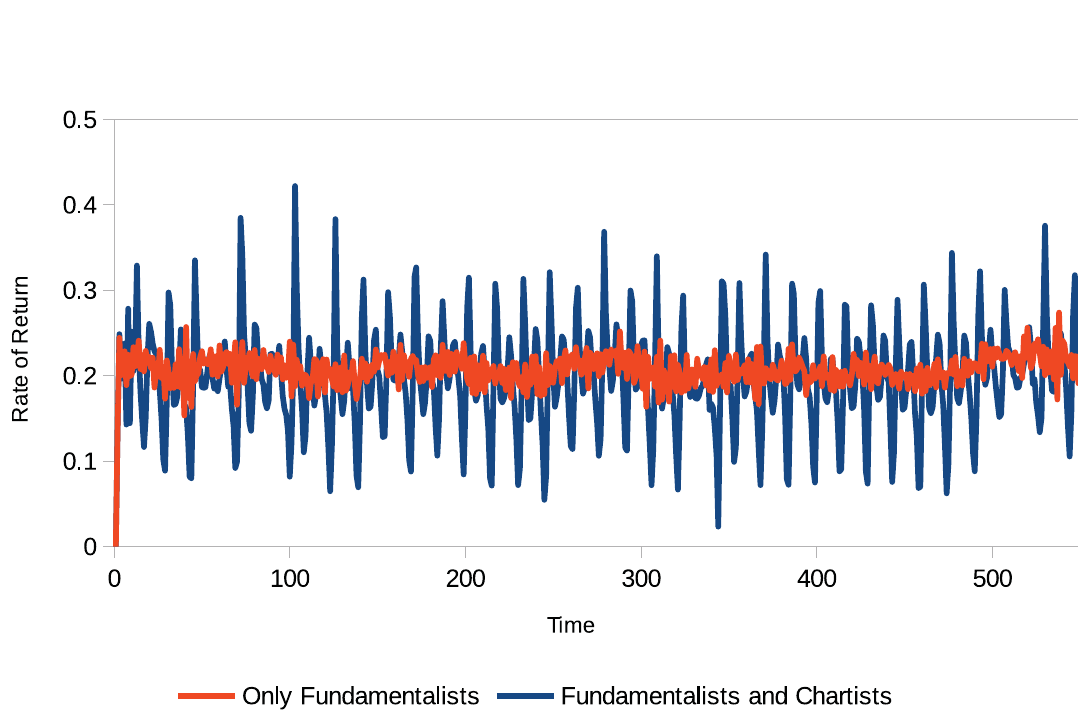
Fig 5. Rate of return (different types of agents with confidence). Source: Own creation.